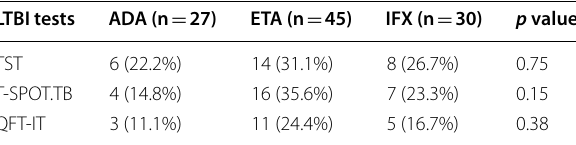
Table 3 Positivity of TST, T‑SPOT.TB and Quantiferon after treatment with TNFα